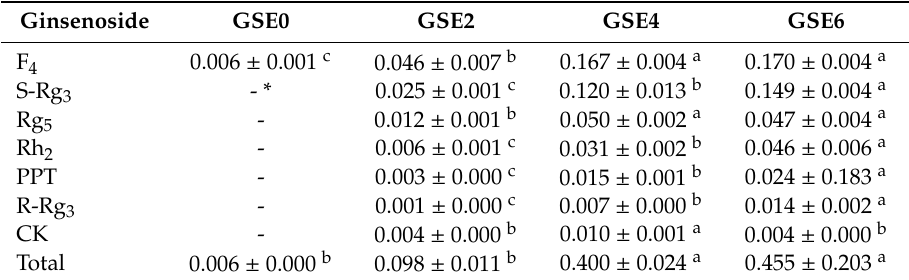
Table 2. Changes in contents of seven less-polar ginsenosides in GSEs0–6 (mg / g). Ginsenoside